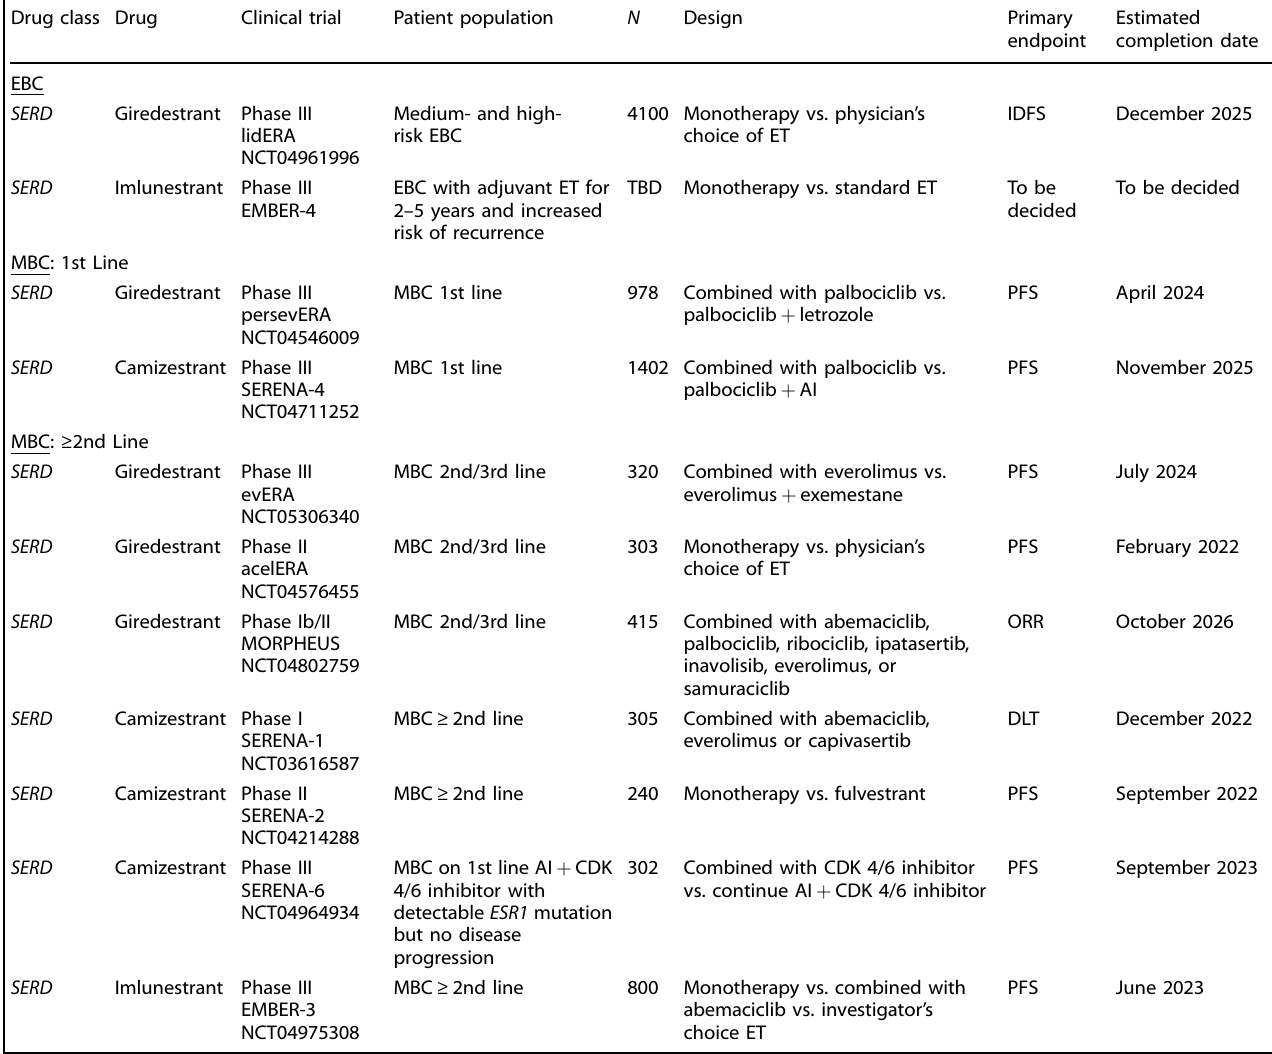
Table 4. Ongoing randomized phase II/phase III trials of novel anti-estrogen therapies. Drug class